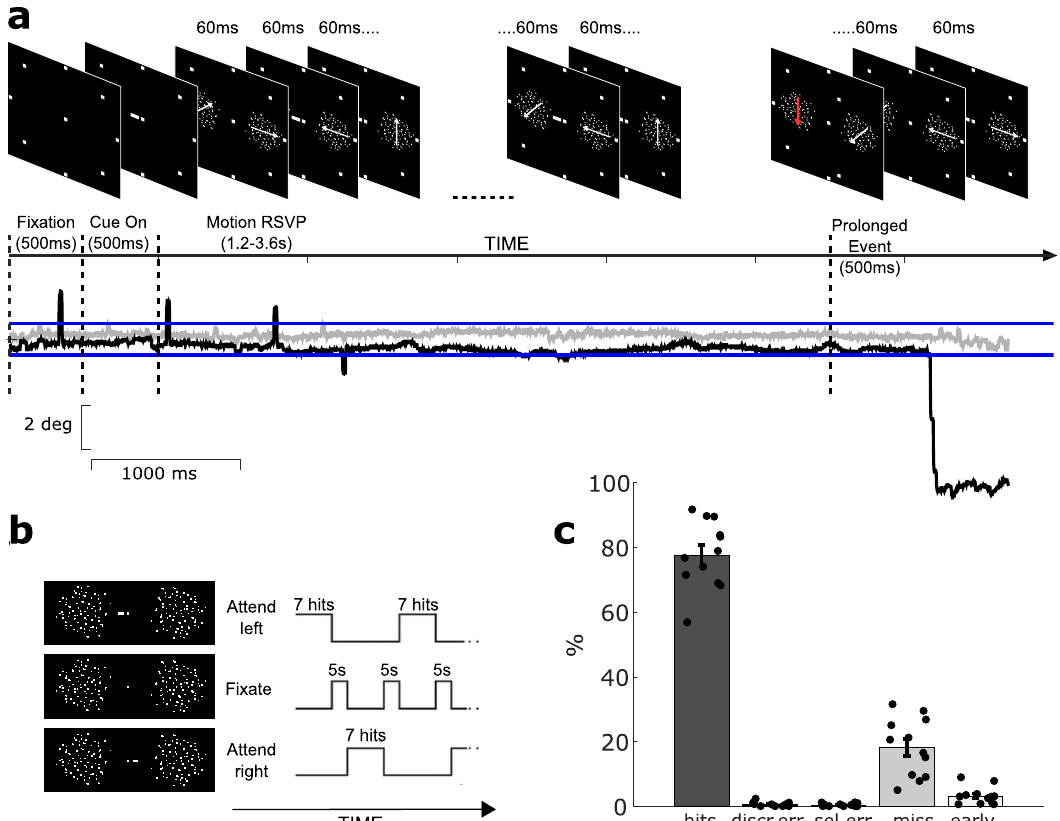
Fig. 2 Experimental design and behavioral performance. a Example trial of the attentive motion discrimination task depicting critical task events. Top row shows display elements of the task; note that they are not drawn in scale (see Methods). Bottom row show an example eye trace corresponding to the trial on top: subjects were required to keep fi xation until the prolonged motion event occurred (see also methods); black and gray solid traces represent x and y axes, respectively; dashed lines mark critical task events; blue lines show the tolerance window for eye movements (±1 deg. visual angle); spikes in the eye traces correspond to eye blinks and were not considered as breaks in fi xation. b Schematic of the block design adopted during scanning. The experiment included three types of block: ‘ Attend left ’ and ‘ Attend right ’ where the task described in A was preformed; ‘ Passive Fixation ’ blocks where the trial structure was exactly the same as in the attention trials, but no attentional cue was displayed. Subjects alternated between paying attention to the right, passive fi xation, and paying attention to the left. During the “ right ” and “ left ” blocks, subjects had to detect and discriminate a motion event at the cued location, while ignoring similar visual stimulation at the irrelevant location. During passive fi xation blocks, the trial structure was the same as the attention blocks, but subjects were required to passively fi xate the central spot while the moving stimuli were displayed. See also Methods. c Behavioral performance of human subjects. In each trial, of the 8 possible motion directions, one was chosen for the target, and a different one was chosen for the distractor. This resulted in fi ve main behavioral outcomes: the subject could saccade into the motion direction displayed by the target ( “ hit ” ) or the direction of the distracter ( “ selection error ” ) or to 1 of 6 remaining targets ( “ discrimination error ” ); the subject could fail to respond to the prolonged event ( “ missed detection ” ) or respond before the prolonged event actually occurred ( “ early selection ” ). Data are expressed as mean across 12 subjects; gray points represent the values for each individual subject. Source data are provided as a Source Data fi